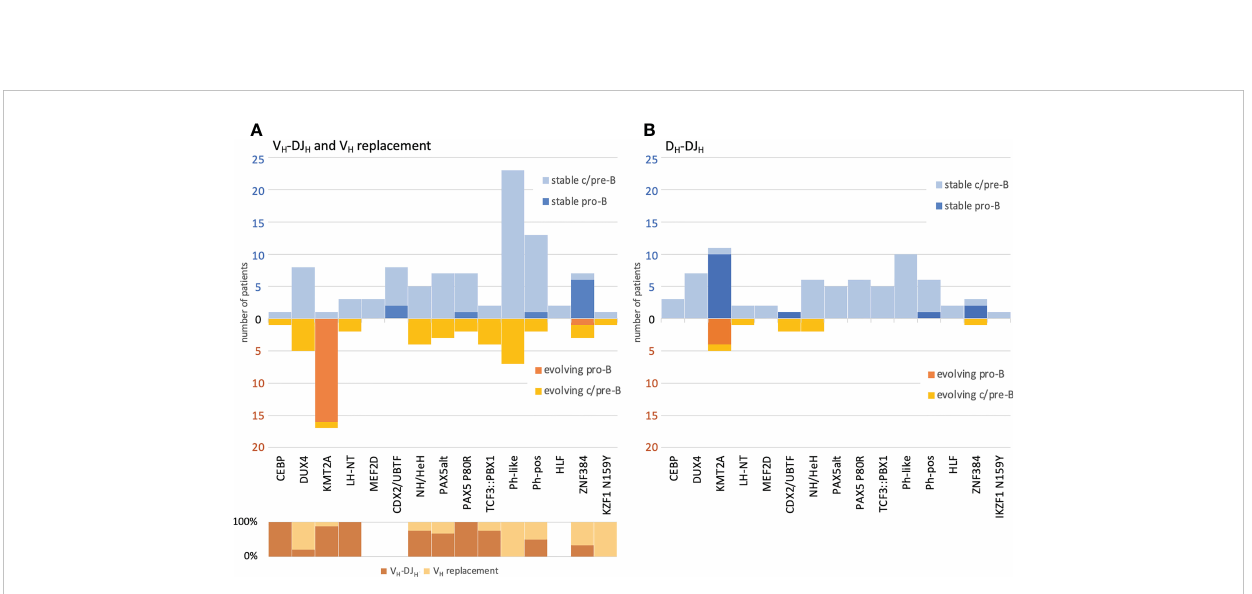
FIGURE 6 Correlation of BCP-ALL immunophenotype and molecular subtypes versus IGH clonal evolution and its respective mechanisms. VH replacement and VH-DJH recombination (A) and DH-DJH recombination (B) . The numbers and classi fi cations are derived from the one-stem-per-case data depicted also in Figure 5. All cases have been labelled by (i) immunophenotype and (ii) their respective molecular subtype as assigned by the transcriptome analysis. Evolving DNJ-stems (warm colors) are shown below the X-axis line and stable DNJ-stems (cold colors) are shown above the X-axis line. For the evolving DNJ-stems, the respective mechanism driving clonal evolution in % of cases has been depicted in the lower left part of the schematic in (A)